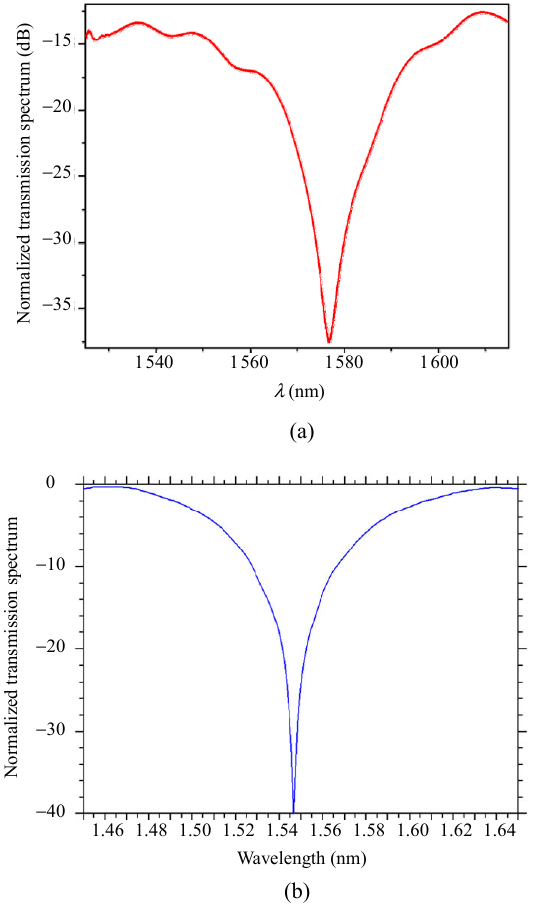
Fig. 6 Device transmission spectrum: (a) device transmission spectrum after experimental testing and data processing by origin and (b) simulated transmission spectrum by